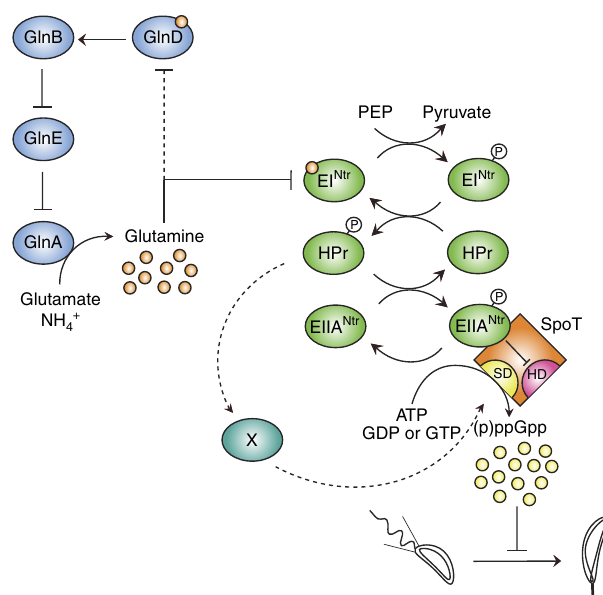
Figure 8 | PTS Ntr -dependent accumulation of (p)ppGpp upon glutamine deprivation. The GlnD/GlnB/GlnE pathway (in blue) regulates glutamine homoeostasis by modulating GlnA (GS) activity. Intracellular glutamine inhibits EI Ntr autophosphorylation, limiting the (p)ppGpp production in þ N conditions. Note that the GlnD activity is very likely also inhibited by intracellular glutamine. On nitrogen starvation, intracellular pool of glutamine drops, relieving inhibition of EI Ntr autophosphorylation and thereby increasing HPr and EIIA Ntr phosphorylation levels (in green). Once phosphorylated, EIIA Ntr B P interacts with SpoT to inhibit its hydrolase activity (HD), whereas HPr B P regulates indirectly SpoTsynthetase activity (SD). This dual control of SpoT by HPr B P and EIIA Ntr B P leads to (p)ppGpp accumulation, which in turn delays the G1-to-S and swarmer-to- stalked cell